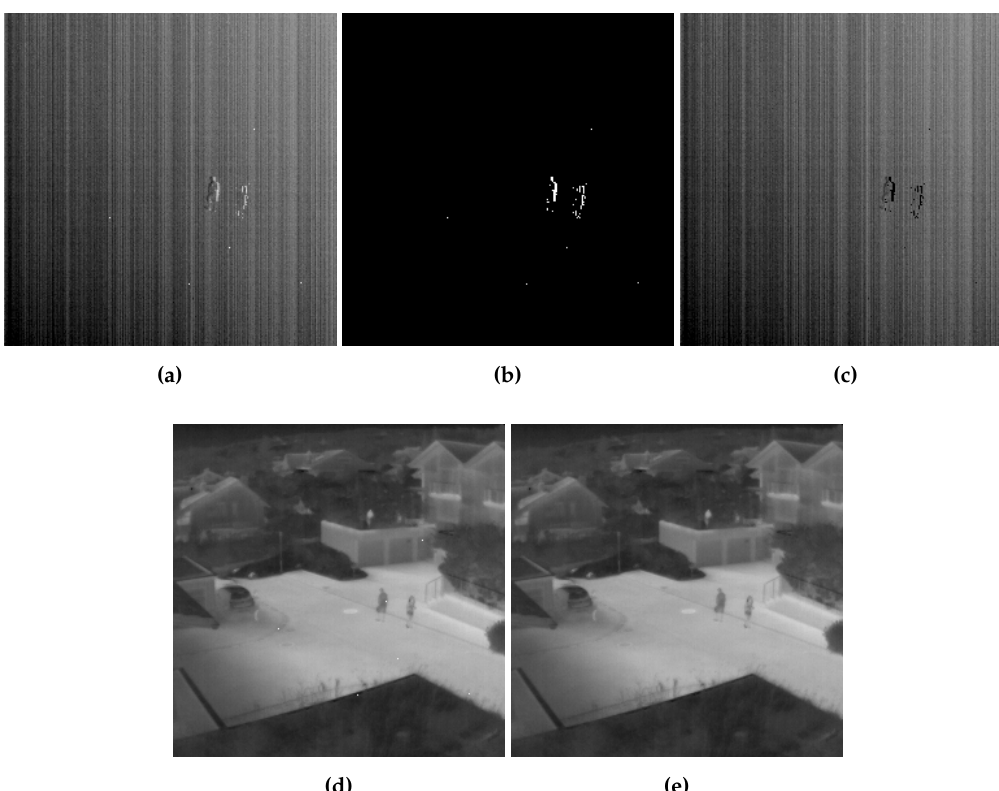
Figure 9. ( a ) registration error; ( b ) abnormal data; ( c ) resulting error used in the correction process; and ( d ) corrected frame without bad pixel replacement; and ( e ) corrected frame with bad pixel